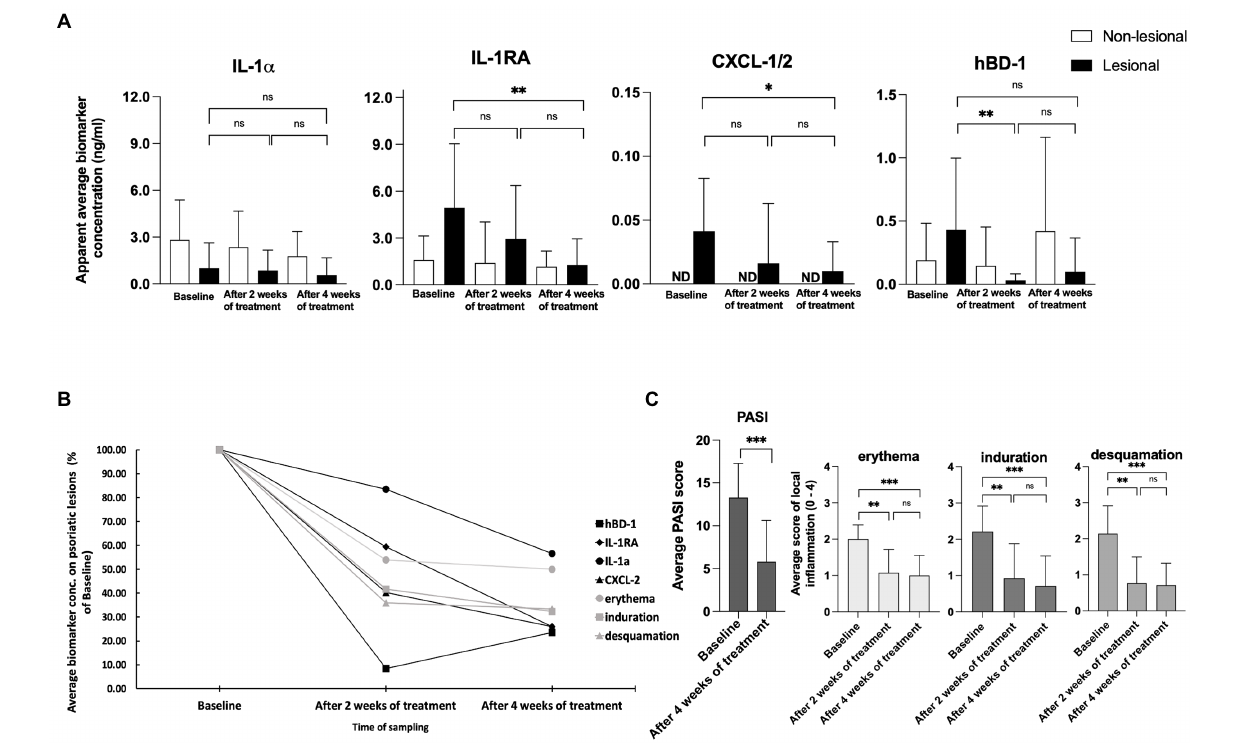
FIGURE 3 (A) Measurements of IL-1 ⍺ , IL-1RA, CXCL-1/2, and hBD-1 on non-lesional and lesional skin of psoriasis patients during narrow band UVB treatment. Biomarker measurements were performed on healthy apparent and lesional skin before treatment, and after two and four weeks of treatment at the same skin site using FibroTx TAP. The apparent average biomarker concentration of non-lesional skin is plotted with white bars (panels A–D), and average biomarker measurements of lesional skin sites are presented with back bars (panels A–D). Y -axis: apparent concentration of IL-1 α , IL-1RA, CXCL-1/2, and hBD-1 on the skin in ng/mL. X -axis: time point of biomarker sampling. Error bars in graphs A–D represent the standard deviations from the average of combined measurements of the patients ( N = 14); ND, not detected. Statistical significance was determined with paired sample